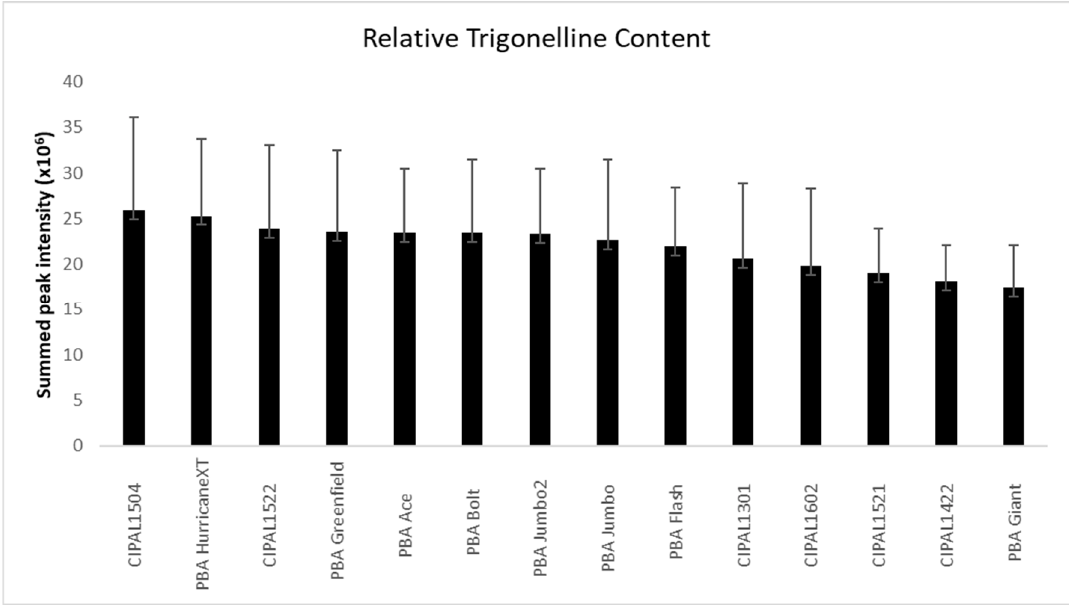
Figure 2. Relative trigonelline content in the lentil genotypes with standard deviation (error bars).